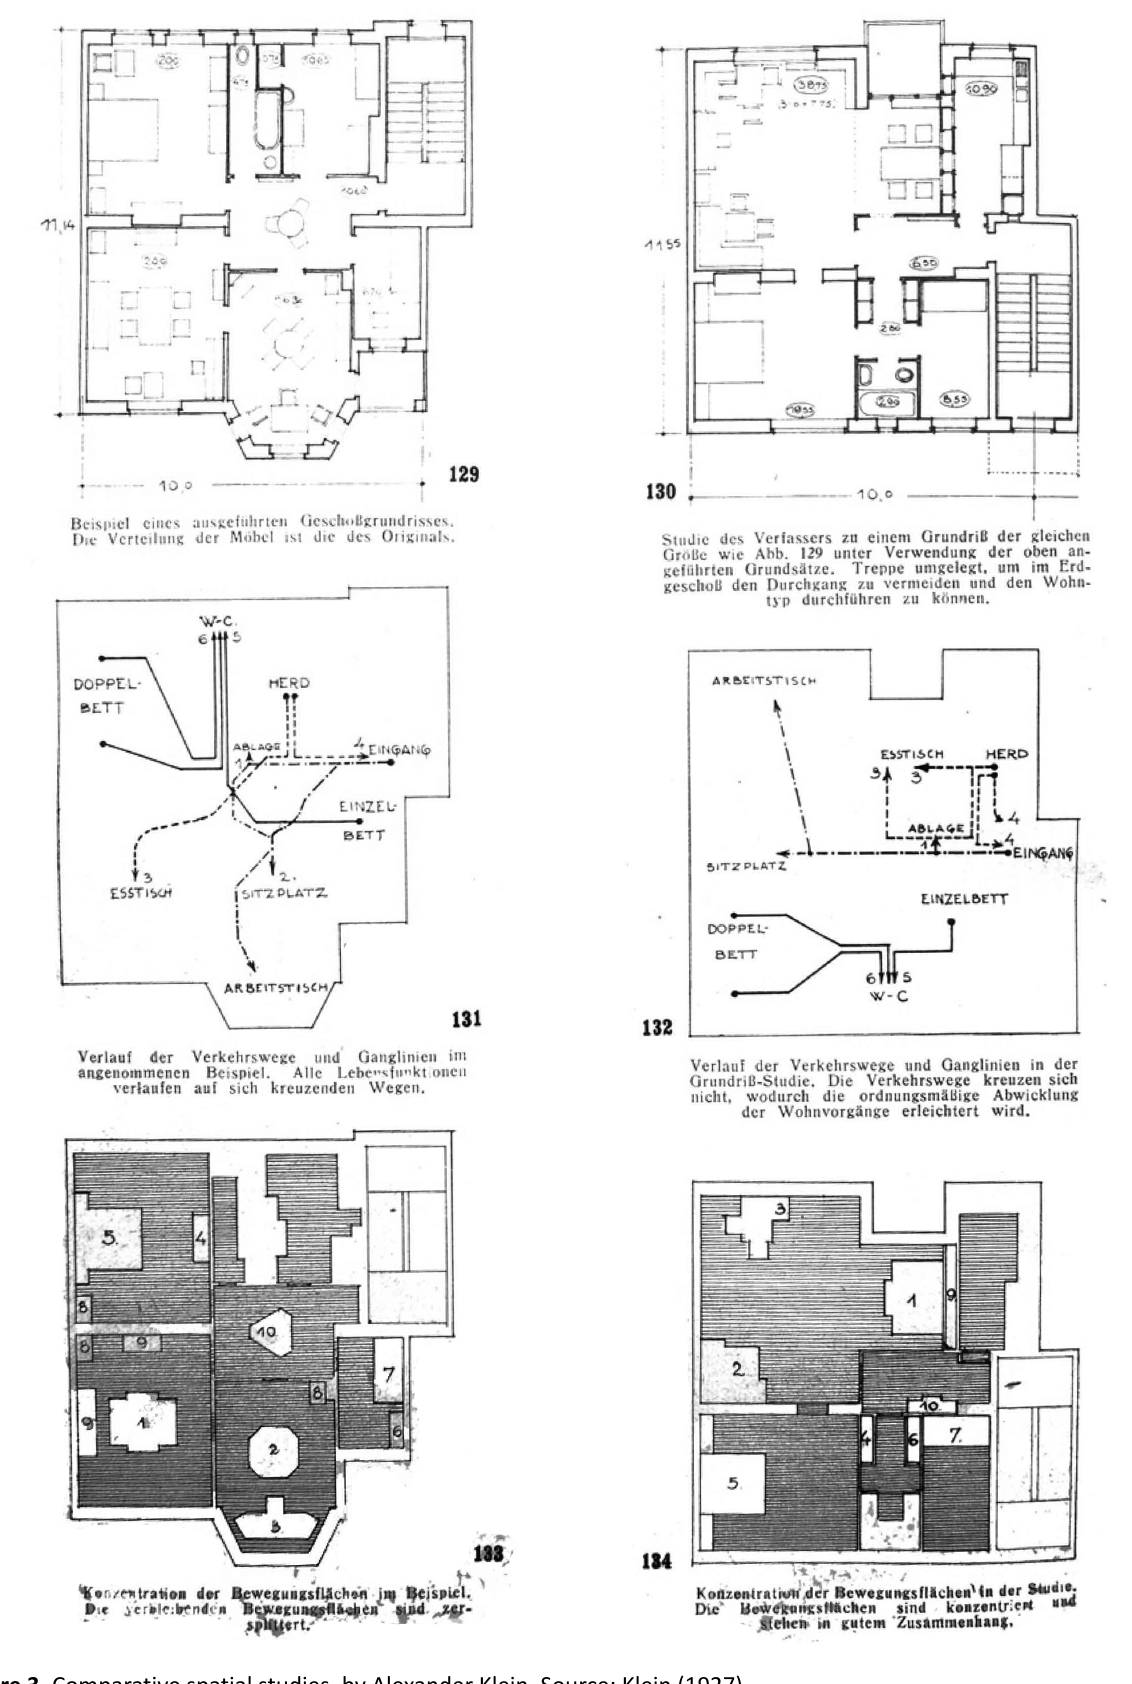
Figure 3. Comparative spatial studies, by Alexander Klein. Source: Klein